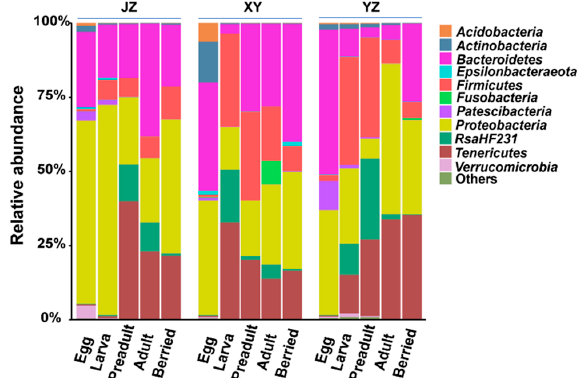
Figure 2. Relative abundances of the dominant bacteria at phyla level. Proteobacteria , Bacteroidetes , Firmicutes , Tenericutes and RsaHF231 were most dominant across samples. JZ: Jingzhou, XY: Xuyi, and YZ: Yangzhou.